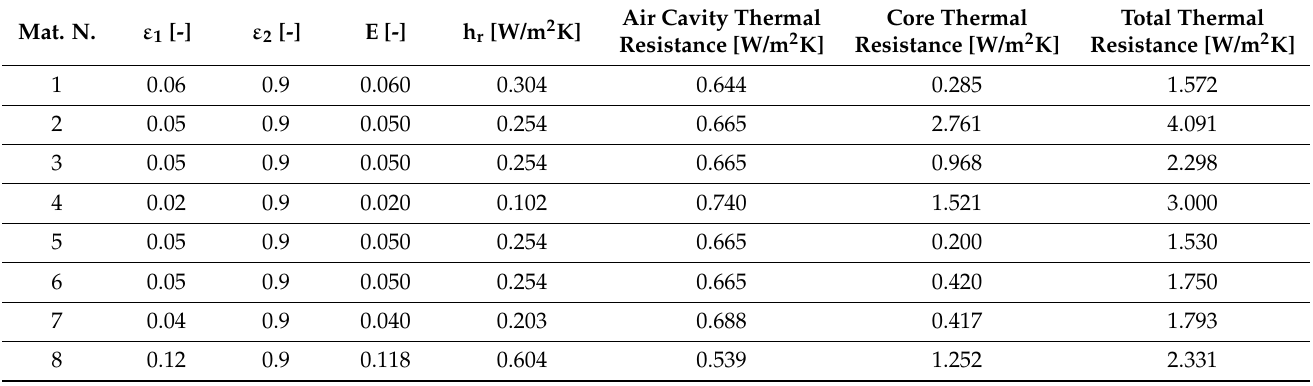
Table 5. Calculated thermal transmittance for eight heat reflective thermal insulation materials – main results.